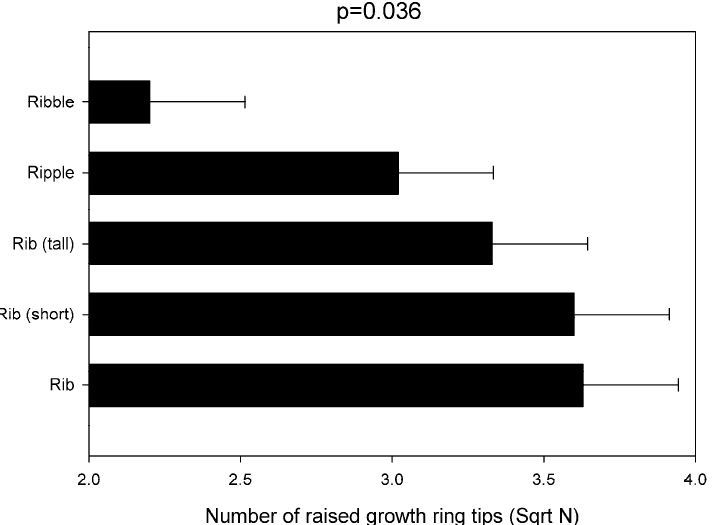
Figure 10. Effects of profile type on the numbers of latewood tips that projected above the surface of profiled western larch deckboards exposed to natural weathering for seven months in Vancouver, Canada. Results are averaged across boards with different growth ring orientations because there was no significant ( p > 0.05) interaction of growth ring orientation and profile type on numbers of raised latewood tips. Error bars = Least significant difference, p < 0.05.